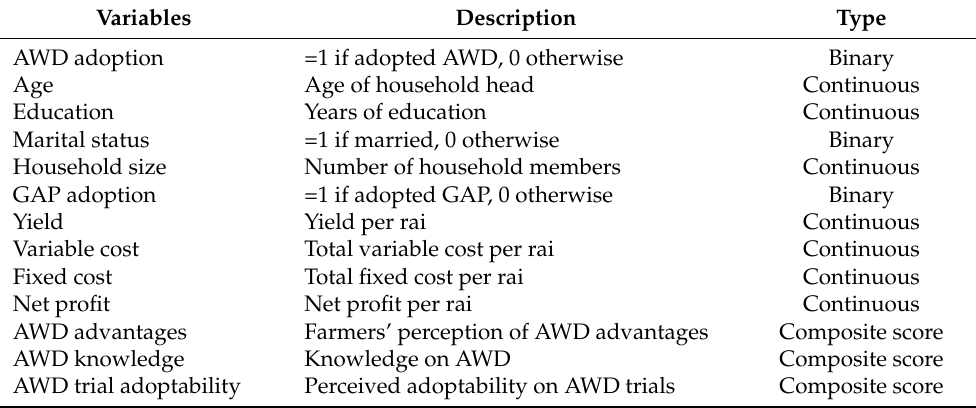
Table 3. Definitions of variables.